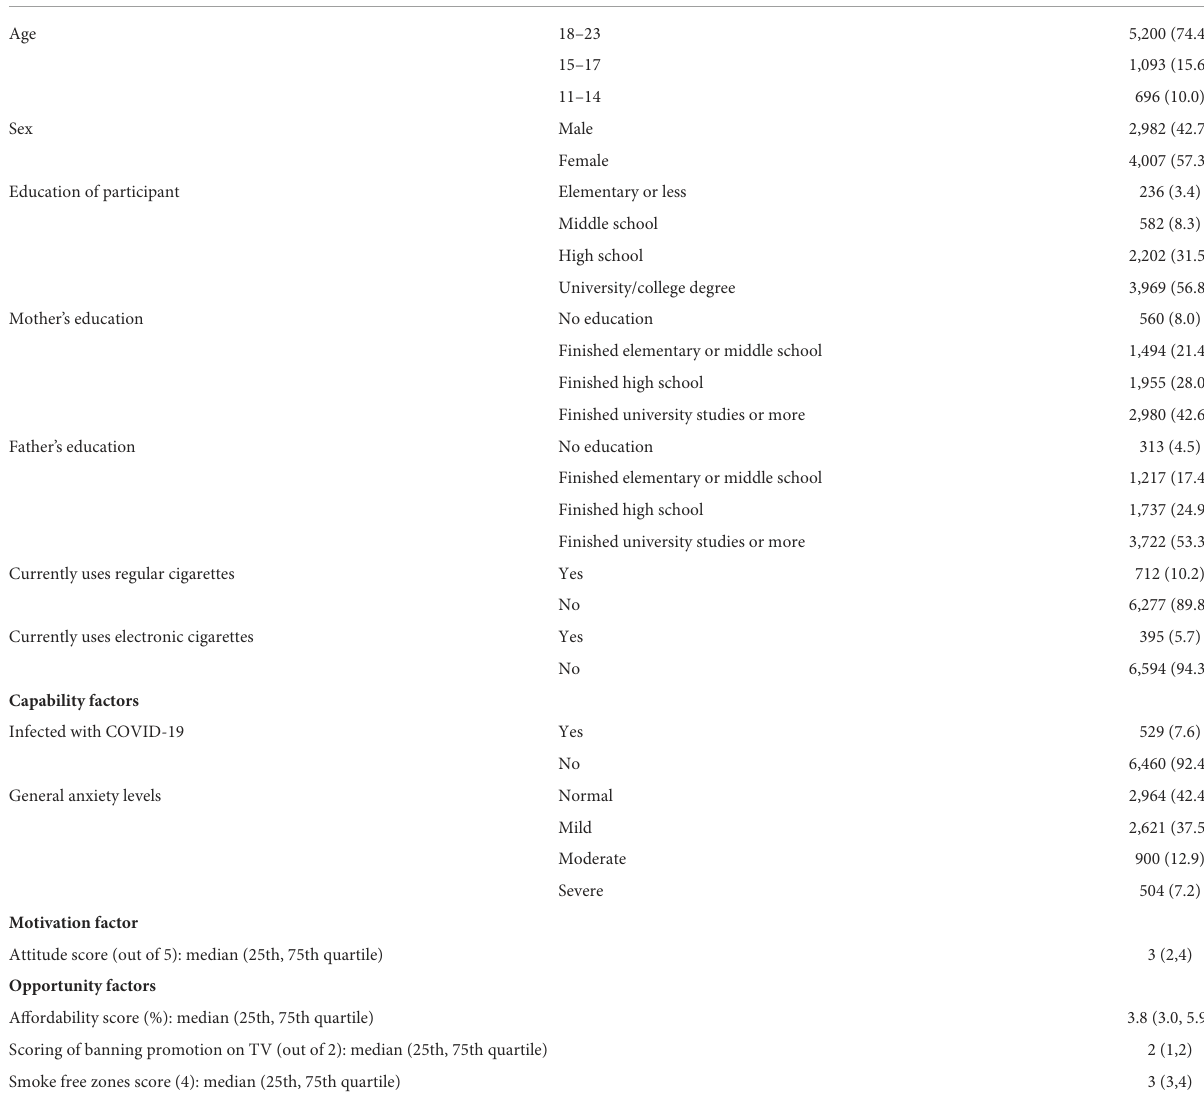
TABLE 1 Sociodemographic, capability, opportunity and motivation factors ( n = 6,989).